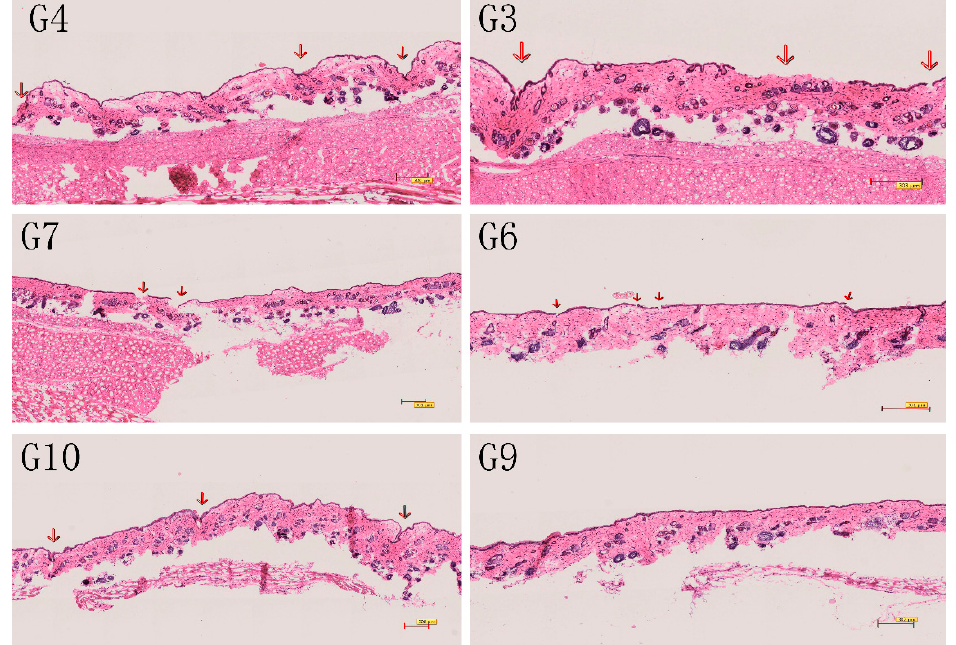
Figure 5. Skin state 2 h after microneedle application (G3) MN condition of group 3, 750 μ m ‐ 2 min ‐ 3 N; (G4) MN condition of group 4, 1000 μ m ‐ 2 min ‐ 3 N; (G6) MN condition of group 6, 500 μ m ‐ 2 min ‐ 5 N; (G7) MN condition of group 7, 500 μ m ‐ 2 min ‐ 7 N; (G9) MN condition of group 9, 500 μ m ‐ 3 min ‐ 3 N; (G10) MN condition of group 10, 500 μ m ‐ 5 min ‐ 3 N.